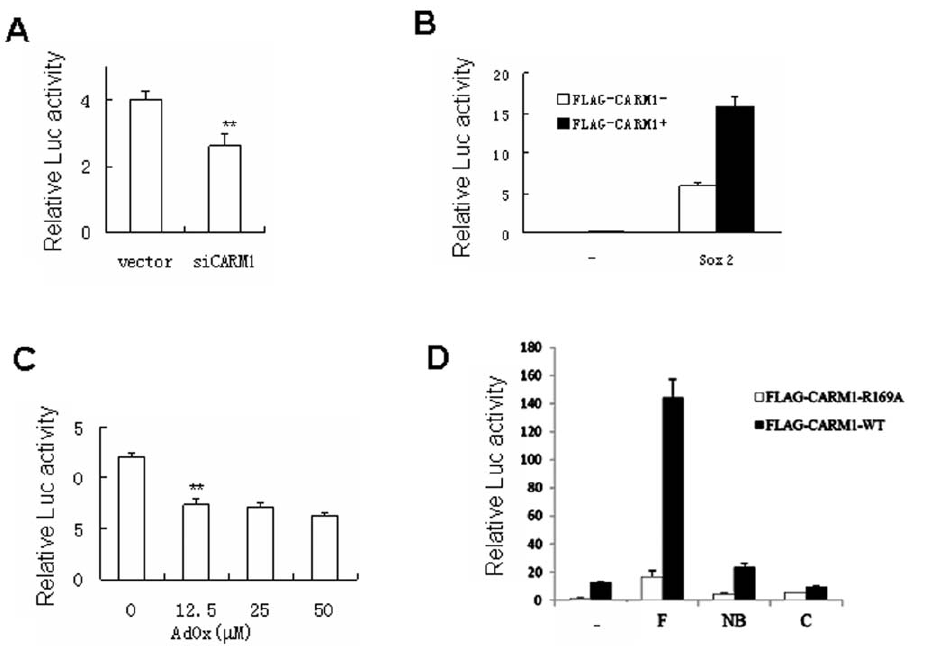
Figure 2. CARM1 facilitates Sox2 transactivation activity. (A) The effect of CARM1 knockdown on Sox2 mediated reporter activity assay. FLAG- Sox2 and the luciferase reporter plasmid (8 6 S/O-Luc) were co-transfected into MCF7 cells with either the plasmid of RNAi vector or siCARM1. (B) The effect of CARM1 overexpression on Sox2-mediated reporter activity. Wild-type Sox2 and its expression vector were individually transfected into MCF7 cells with or without FLAG-CARM1. (C) The effect of AdOx on Sox2-mediated reporter activity. MCF7 cells were first transfected with the 8 6 S/O-Luc reporter and FLAG-Sox2 for 24 hours. The cells were then treated with different concentrations of AdOx as indicated for another 24 hours before harvest for reporter activity assay. (D) The effect of CARM1-WT and CARM1-R169A overexpression on Sox2-mediated reporter activity. Wild type and truncated Sox2 (as shown in Fig. 1E) and its vector were individually transfected into MCF7 cells with CARM1-WT or CARM1-R169A. Each bar represents mean value 6 S.D. from at least three independent experiments. ** P , 0.01, Student’s t